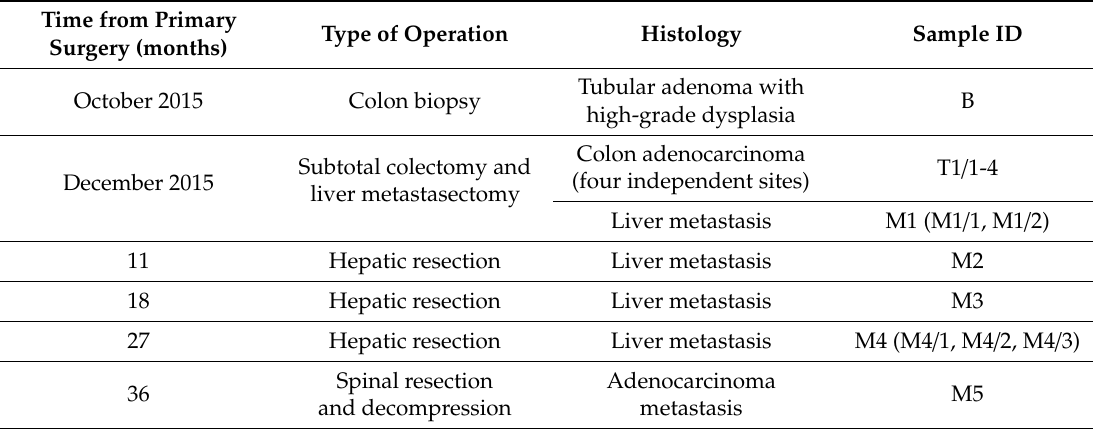
Figure 1. Anatomical localization of the individual primary tumors of the upper colon and of the liver metastases known at the time of the surgery. MX represents liver metastasis described by preoperative CT scan examination but removed later as M2 (hepatic VIII. segment). Table 1. Surgical interventions and histological findings and therapeutic strategy during the course of multiple metastatic colon adenocarcinoma.